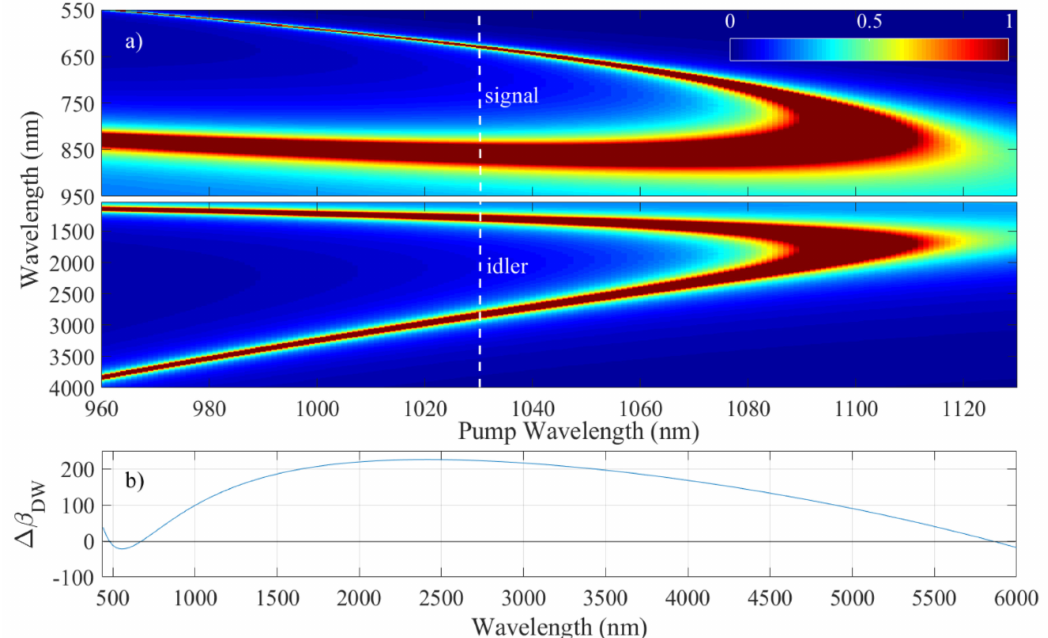
Figure 4. ( a ) Coherence length (1/ κ ) as a function of the pump P 1 wavelength for a constant peak power of 63 MW (from Equation (5). ( b ) Phase mismatch of the dispersive wave ( ∆ β DW ) as a function of the wavelength for the pump P 2 (from Equation (6).